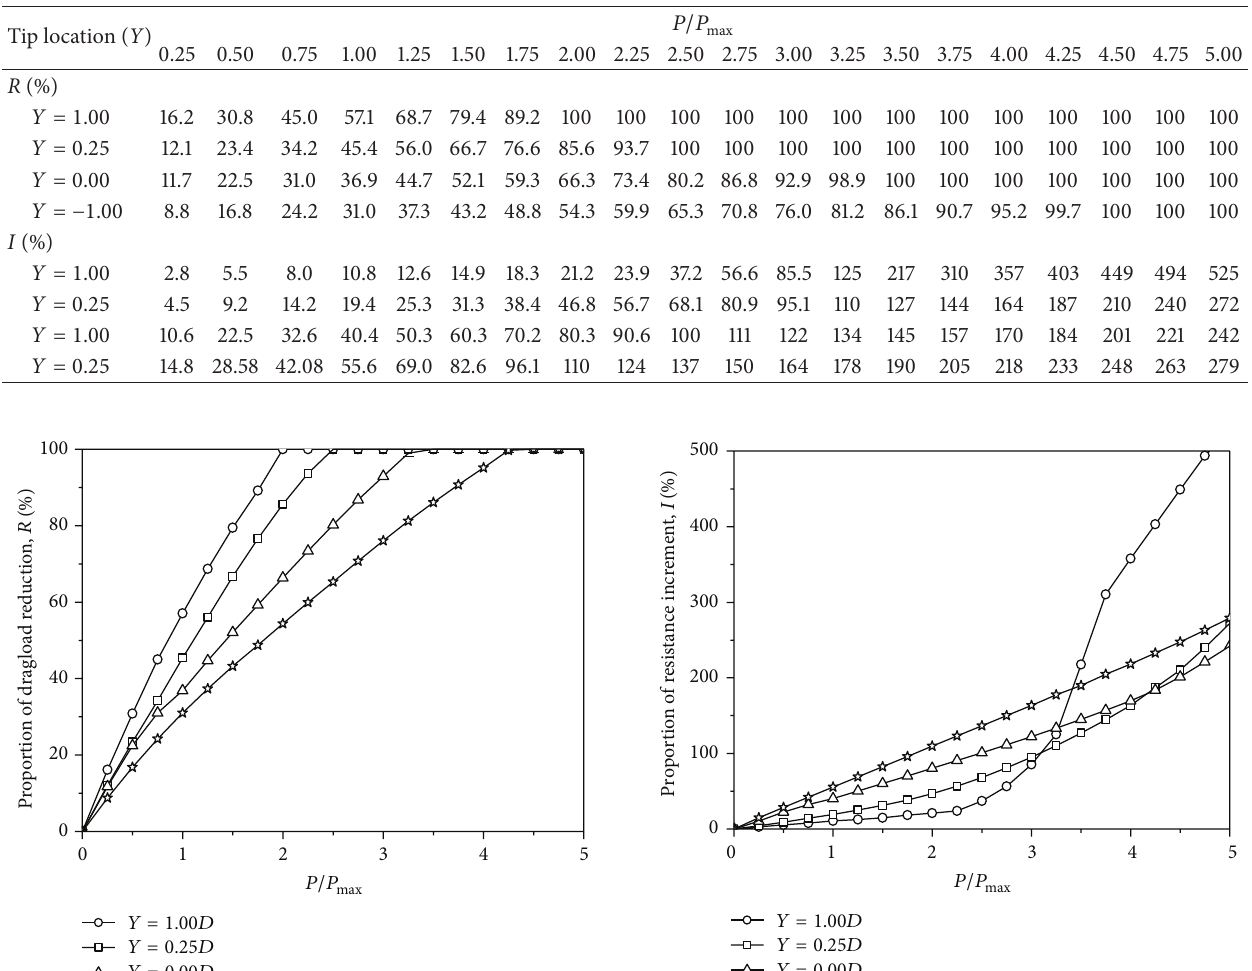
Table 4: Variations of the dragload reduction and base stress increment with the axial load.